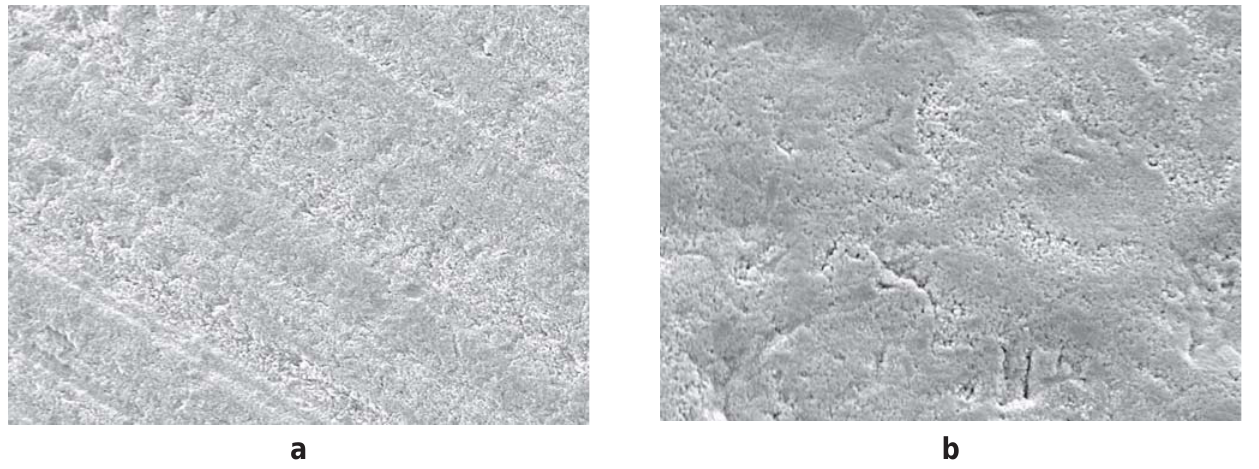
FIGURE 5- SEMs of ground (5a) and intact (5b) enamel surfaces treated with Clearfil Protect Bond self-etching primer. Exposed enamel crystallites were observed in scratches left by the SiC abrasive paper (5a). Superficial layer remnants were observed in intact surfaces (5b) (x10,000)